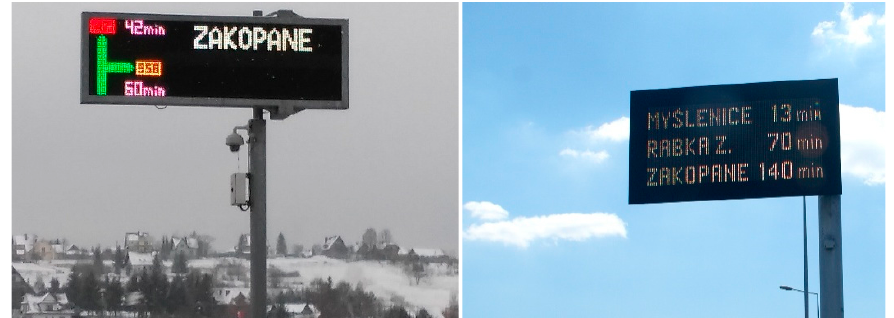
Figure 2. Variable message signs for travel time of the Travel Time Information System (TTIS).